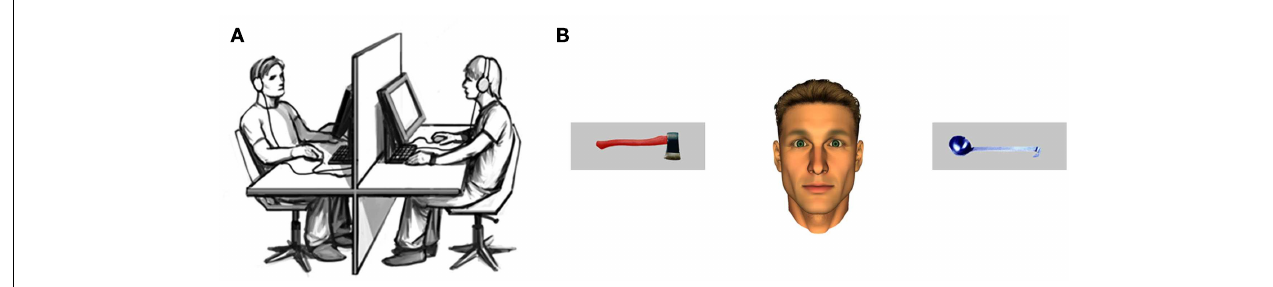
FIGURE 1 | (A) Illustration of the interactive eye-tracking setup with the real participant on one side and the interaction partner – a confederate of the experimenter – on the other (taken from Pfeiffer et al., 2011, p. 2). (B) Example trial depicting the male anthropomorphic virtual character and pictures of two real-life